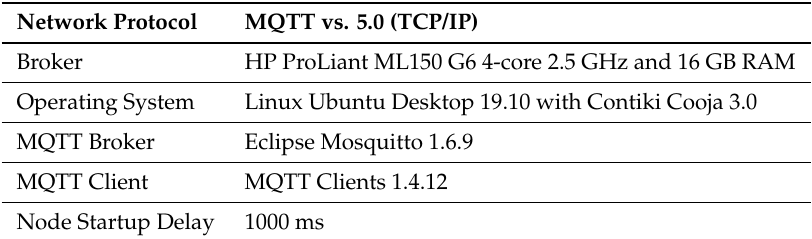
Table 1. Network setting for the